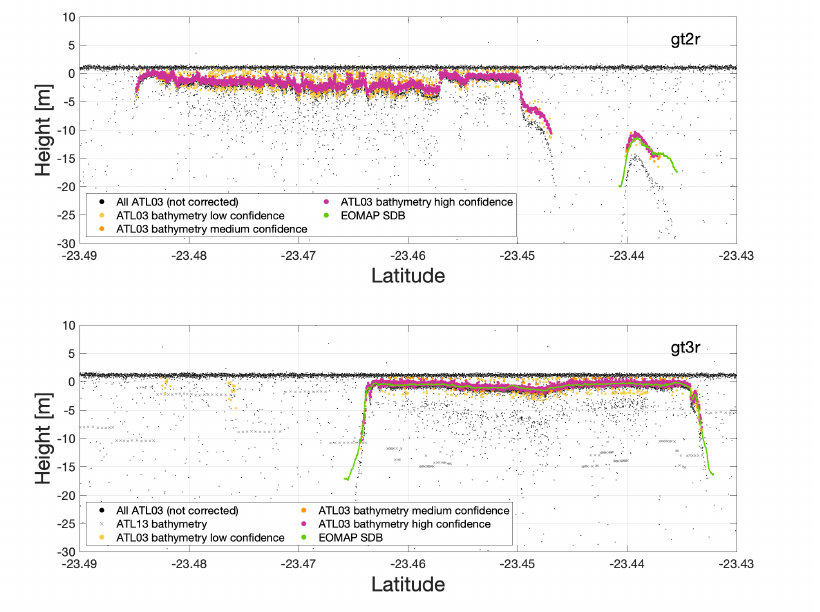
Figure 8. ICESat-2 track crossing Heron Reef on 15 September 2019. ICESat-2 data from ATL13 and ATL03 shown along with SDB data and the GEBCO model.